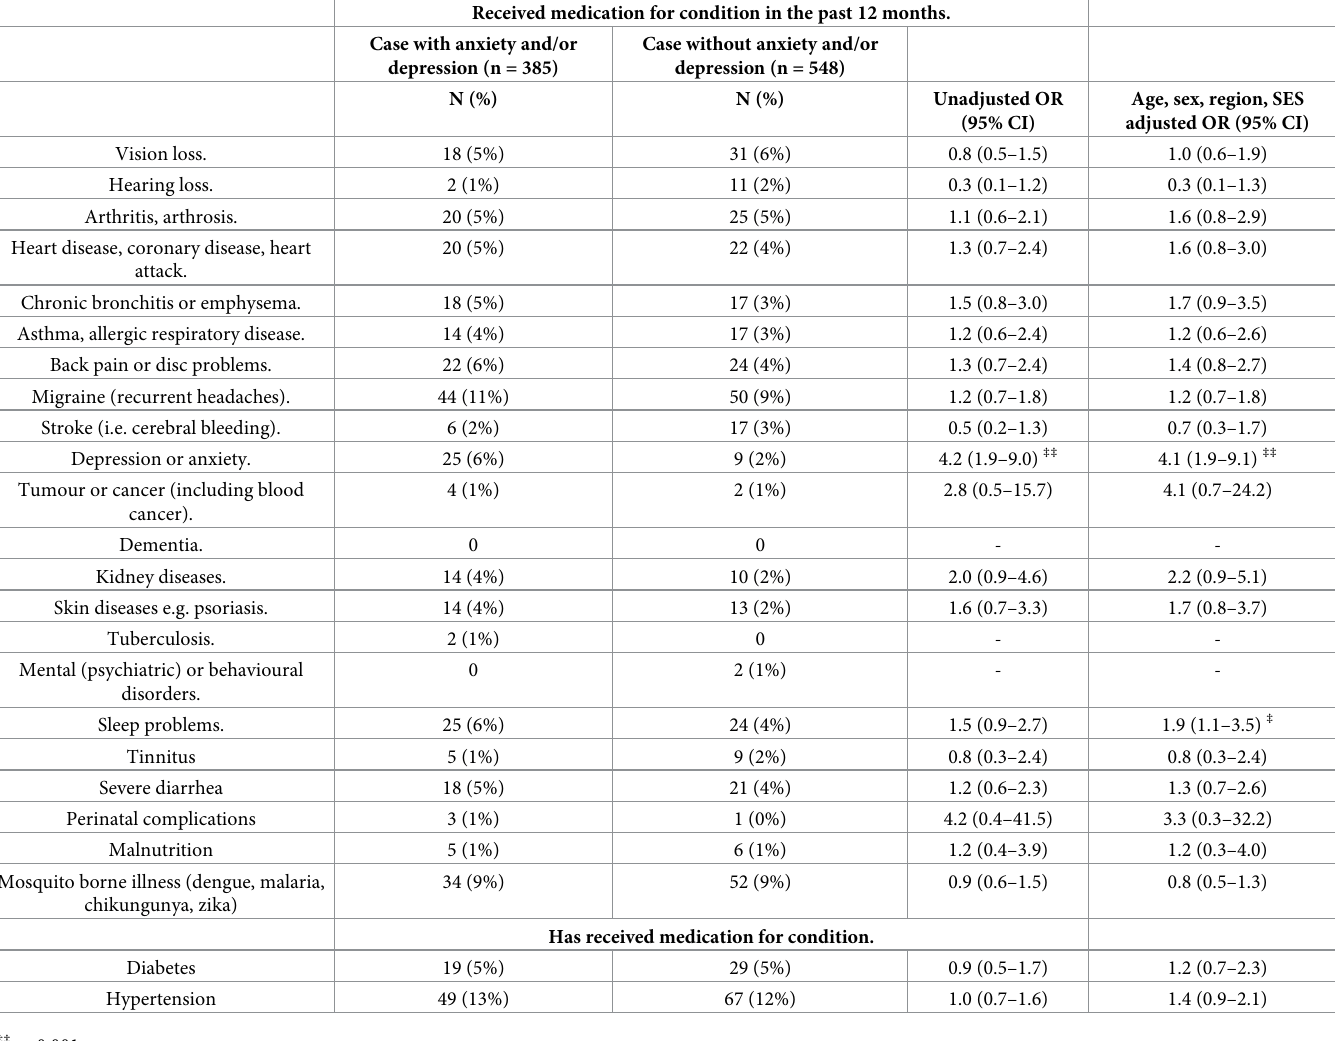
Table 5. Medication/treatment for health conditions diagnosed by doctor, comparing cases with and without anxiety and/or depression. Received medication for condition in the past 12